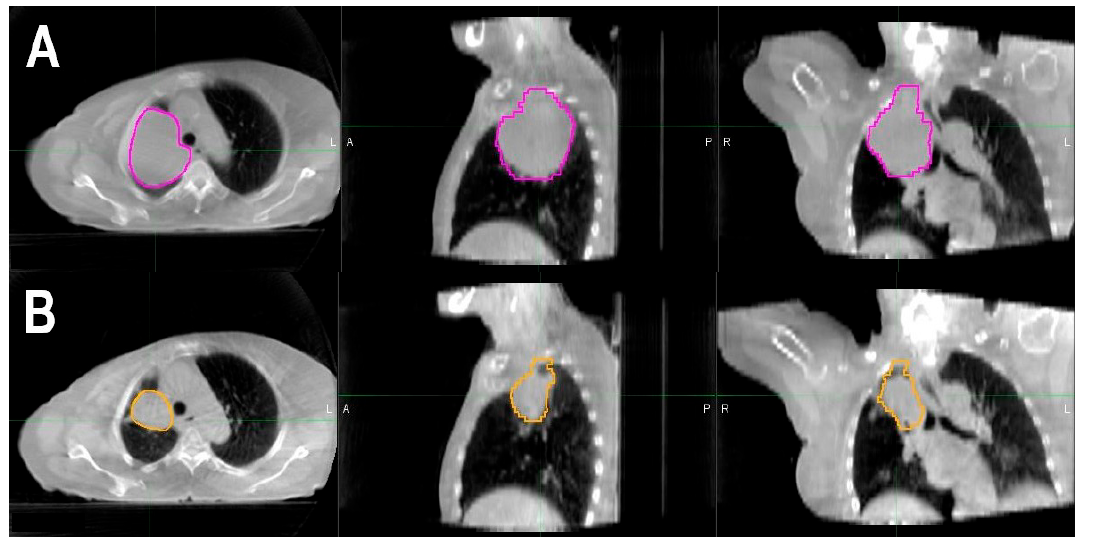
Figure 1. Example of gross tumor volume (GTV) contouring to determine tumor regression during chemoradiation (left to right: axial, sagittal, and coronal views). ( A ) Cone-beam computed tomography (CBCT) of a patient in week 1 of treatment, with GTV contoured in magenta. ( B ) CBCT of the patient in week 6 of treatment, with GTV contoured in gold. Table 3. Univariable and multivariable Cox analysis for recurrence-free and overall survival ( N = 42).